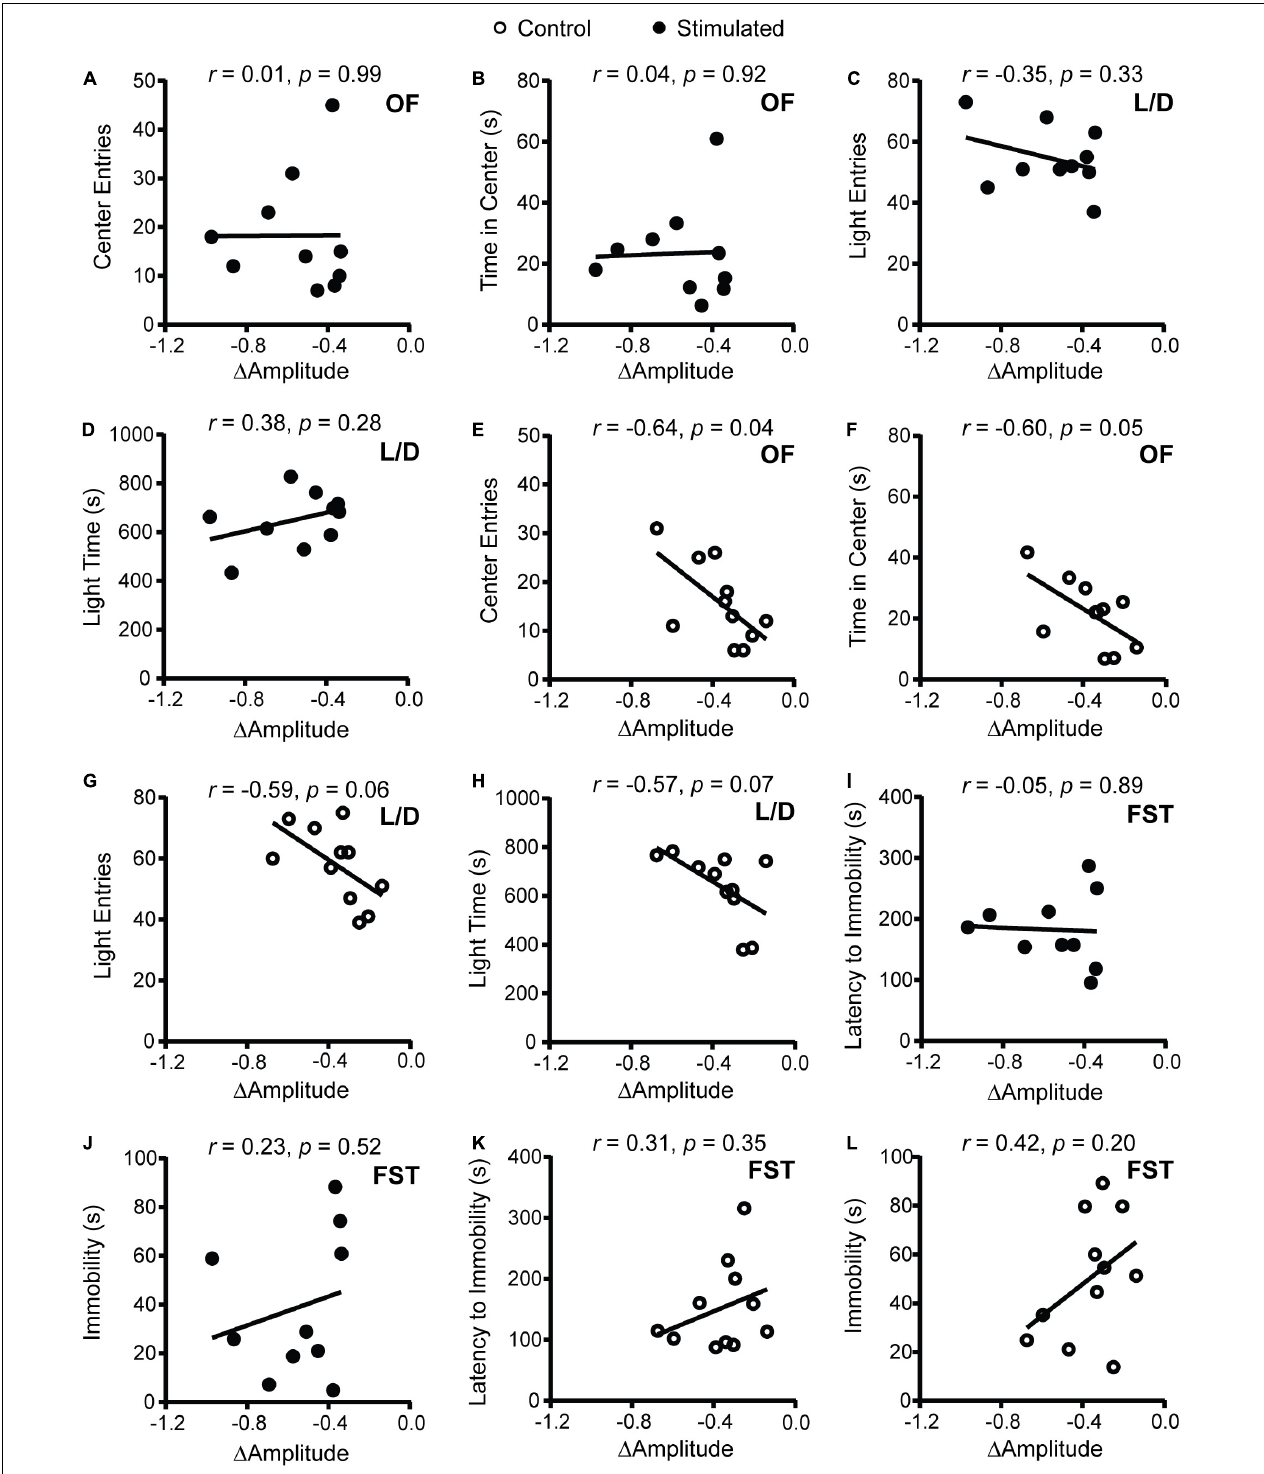
FIGURE 4 | Correlations between change in homecage activity amplitude and behavior in mice that received stimulations or sham stimulations of the SCN at unpredictable times during the dark phase. (A,B,E,F) OF, (C,D,G,H) LD box, and (I–L) FST behavior. A dampened amplitude of homecage activity rhythms in control mice was associated with decreased anxiety-like behavior in the OF. n = 9–11 Vgat -Cre;ChR2 mice.